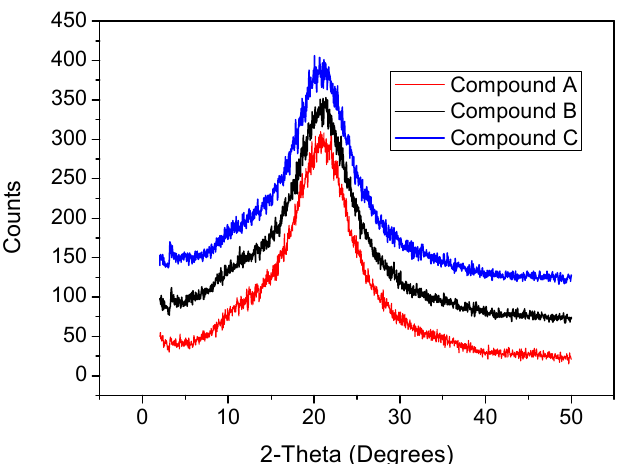
Figure 5. X-ray diffraction (XRD) pattern of thin Films A , B and C